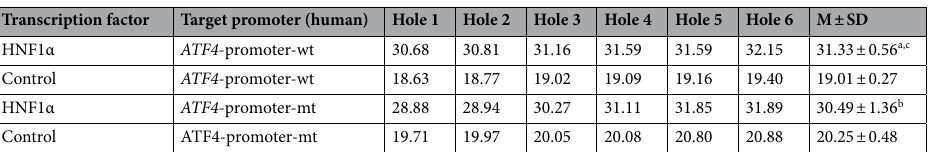
Table 1. Relative luciferase activity (Ratio of Fluc/Rluc). a p < 0.001, HNF1α versus the control group, ATF4 - promoter-wt. b p < 0.001, HNF1α versus the control group, ATF4 -promoter-mt. c p < 0.001, ATF4 -promoter-wt versus ATF4-promoter-mt; mt: mutated type; wt: wild